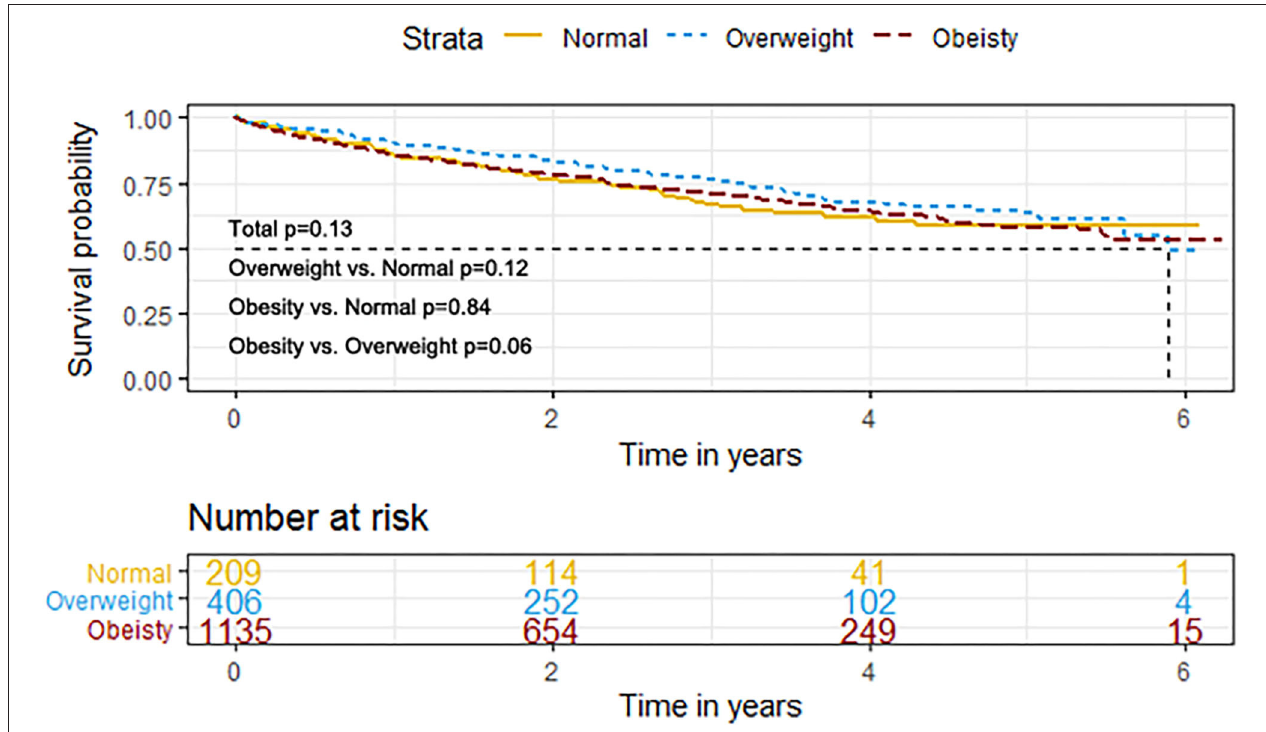
FIGURE 1 | K–M survival curves for the primary composite outcome based on the predefined body mass index (BMI) categories in HFpEF. HFpEF, heart failure with preserved ejection fraction; HF, heart failure.